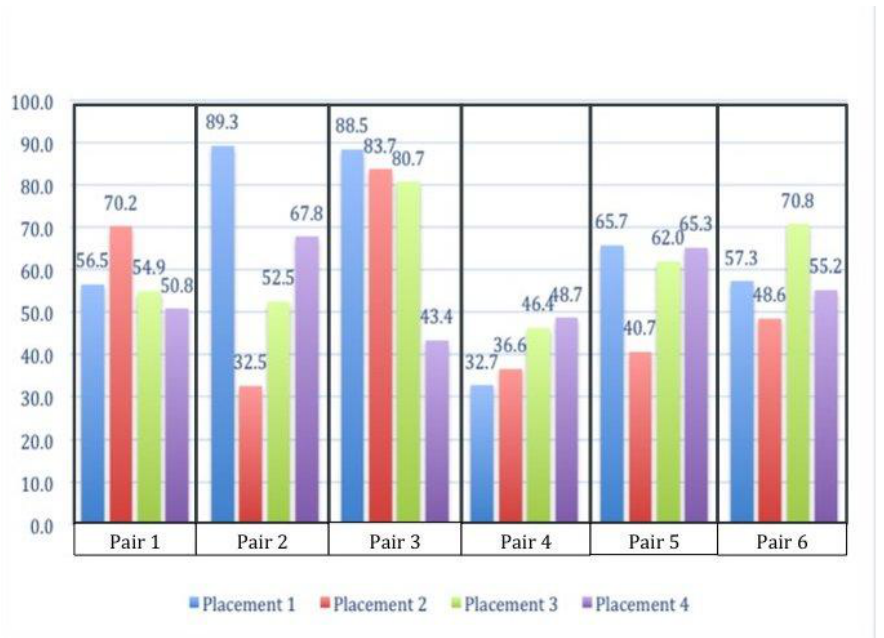
Figure 3. Graphical depiction of the percentages of positive values when activity counts of both devices were subtracted for each epoch for P1-P4. For this calculation, each individual activity count for each epoch was subtracted (Total Activity Device 1 – Total Activity Device 2) and the number of positive ‘subtracted activity counts’ was then divided by the total number of counts during a placement period. As such, a number above 50% indicates a larger recording of Device 1 compared to Device 2. For example, during P2 (for Pair 1), Device 1 showed a greater individual activity count 20.2% of the time but only 4.9% of the time during P3. P1 is depicted in blue, P2 in red, P3 in green, and P4 in